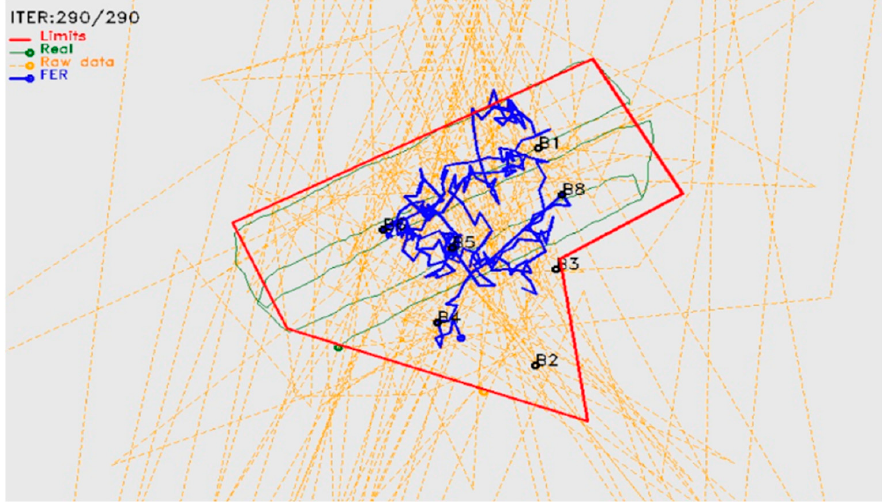
Figure 8. SheepIT localization algorithm.